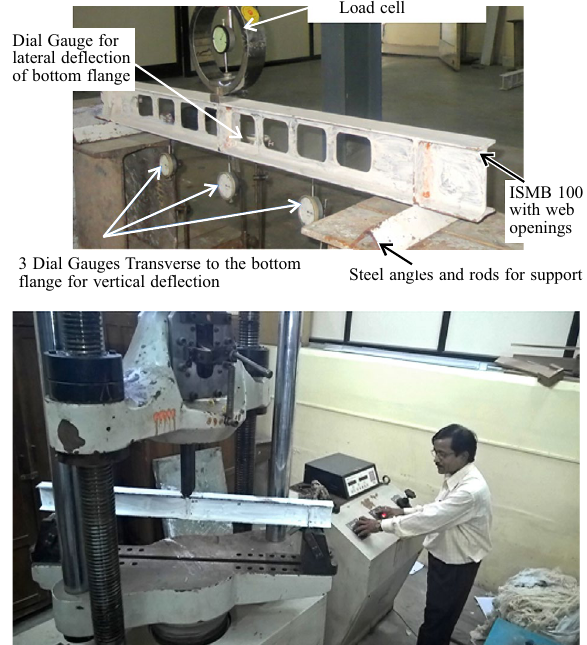
Fig. 4. Experimental test-set of beam